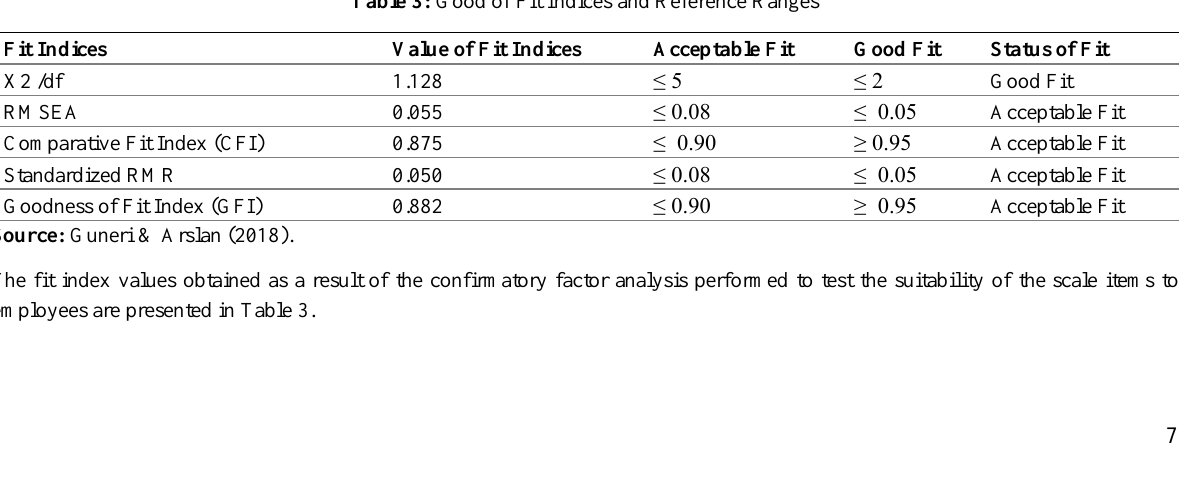
Table 3: Good of Fit Indices and Reference